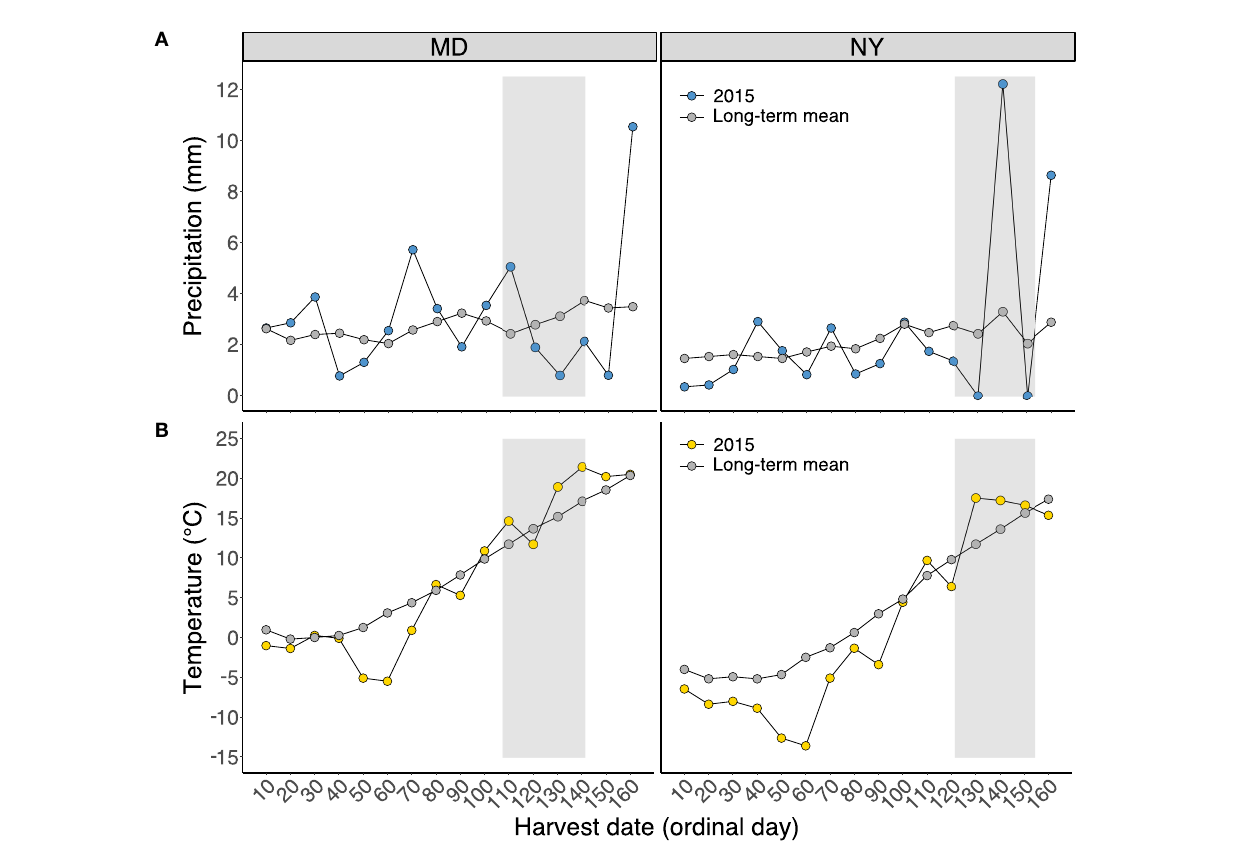
FIGURE1 Mean daily (A) precipitation (mm) and (B) temperature ( ◦ C) for Beltsville, MD, and Aurora, NY, in 2015 for each 10-day interval beginning January 1 (day 1) through June 9 (day 160). The long-term mean represents the mean daily precipitation or temperature summarized using the earliest year of recorded weather station data associated with each field site: 1941–2014 for MD and 1956–2014 for NY (Northeast Regional Climate Center, 2022). Shaded regions indicate the sampling period, ranging from the first to the last harvest date in each